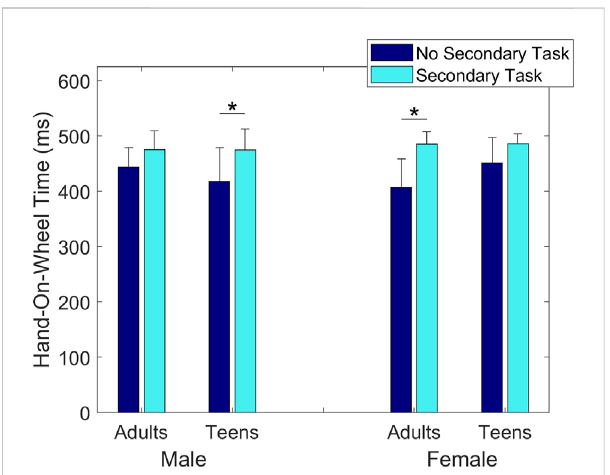
FIGURE 9 Group means ± SD for Hand-On-Wheel Time for each sex and age group of drivers without and with the Secondary Task.